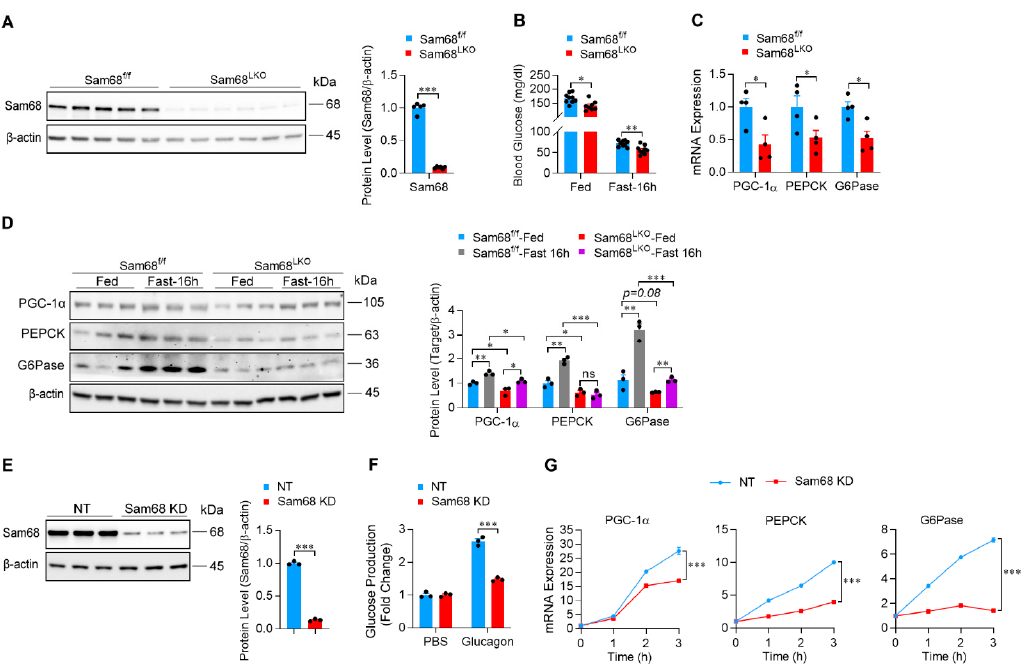
Figure 2. Deletion of hepatic Sam68 attenuates glucagon-induced gluconeogenic gene expression. ( A ) Sam68 protein expression in the liver of Sam68 LKO and Sam68 f/f mice (left panel, representative Western blot; right panel, quantification). n = 5–6. ( B ) Blood glucose levels in the mice under feeding condition or after 16-h fasting. n = 8–9. ( C ) mRNA expression (qRT-PCR) of PGC-1 α , PEPCK, and G6Pase in the liver of mice after 16-h fasting. n = 4. ( D ) Protein expression of PGC-1 α , PEPCK, and G6Pase in the liver of mice under feeding condition or after 16 h fasting (left panel, representative Western blot; right panel, quantification). n = 3. ( E – G ) HepG2 cells were infected with lentiviral vector coding for Sam68-shRNA (KD) or non-targeting shRNA (NT), then the transduced cells were selected in puromycin for 14 days. ( E ) Sam68 protein expression was evaluated (left panel, representative Western blot; right panel, quantification). n = 3. ( F ) Glucose production was measured in the culture media of cells that had been treated with glucagon (100 nM) or PBS for 4 h. n = 3. ( G ) mRNA expression of gluconeogenic genes was measured in cells after treatment with glucagon (100 nM) for 0–3 h ( n = 3). Data are expressed as mean ± s.e.m. * p < 0.05, ** p < 0.01, *** p < 0.001, ns, not significant (( B , C , F ), and right panels of ( A , E ): unpaired t test; G and right panel of ( D ): two-way ANOVA).